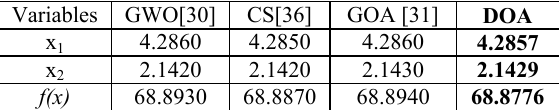
Table 4. Comparison of results for the cone